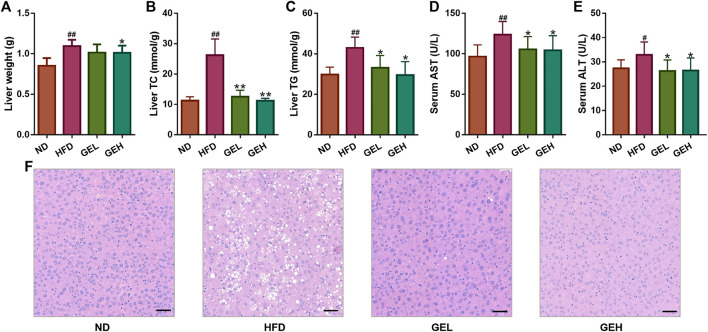
Effects of GE treatment on HFD-induced hepatocyte injury and abnormalities. (A) Liver weight. (B–C) Hepatic lipid levels. (D–E) Serum AST and ALT levels. (F) H&E staining of liver tissues (200× magnification, scale bars = 50 μm). n = 8 per group. #
p <0.05 or ##
p <0.01 vs. the ND group. *p <0.05 or **p <0.01 vs. the HFD group.